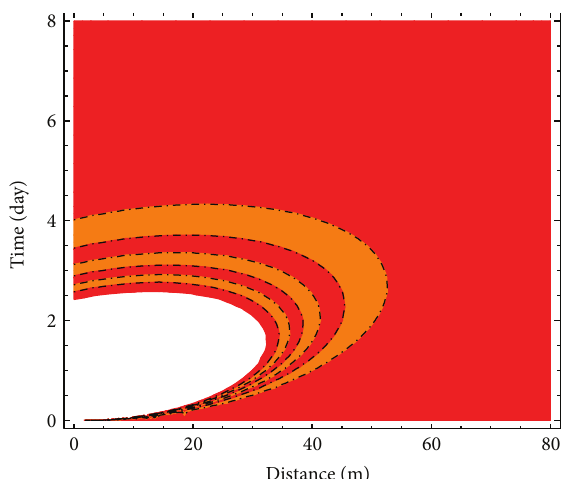
Figure 19: Numerical simulation of the plume as function of time (day) and space (m).